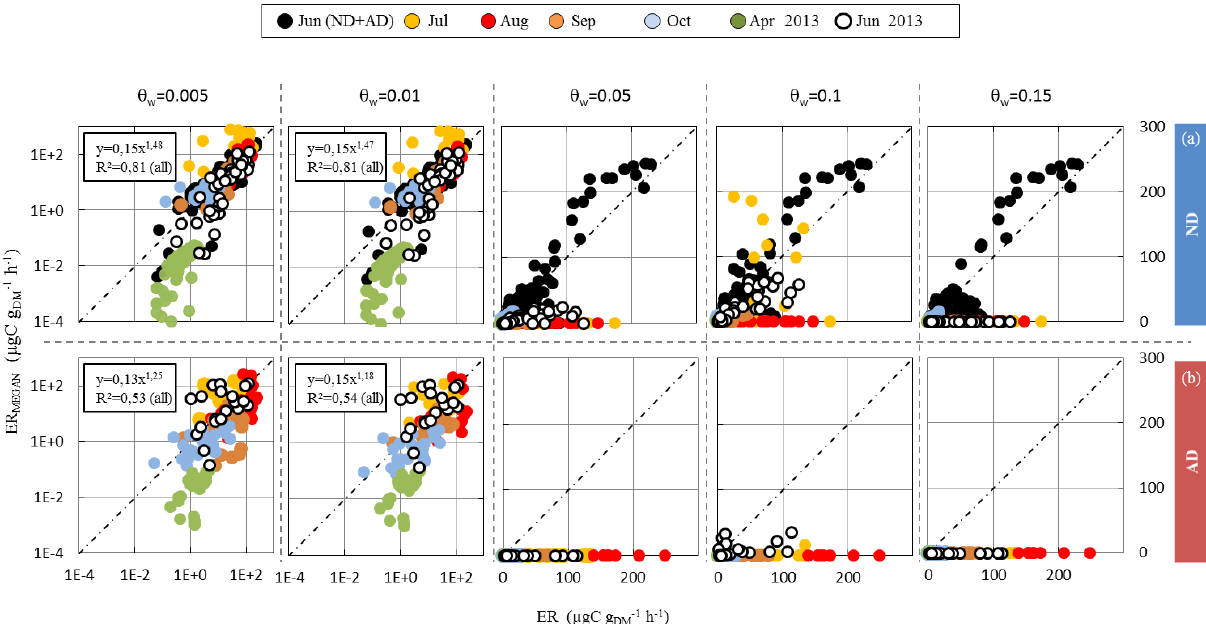
Figure 3. Comparison between isoprene emission rates (in µgCg − 1 h − 1 ) calculated using MEGAN2.1 (ER MEGAN , Guenther et al., 2012) DM and measured isoprene emission rates (ER) vs. the wilting point value θw (0.005 to 0.15m 3 m − 3 ) , from June 2012 to June 2013, under (a) ND ( n = 267) and (b) AD ( n = 138). Since the rain exclusion device was only implemented soon prior to our study’s commencement in June 2012, the ND and AD measurements were considered together for June 2012. Linear regressions for ND June 2012 were y = 1 . 13 x − 12 . 05, R 2 = 0 . 80 ( θw = 0.05m 3 m − 3 ) ; y = 1 . 13 x − 7 . 13, R 2 = 0 . 80 ( θw = 0 . 1m 3 m − 3 ) ; and y = 1 . 12 x − 16 . 94, R 2 = 0 . 76 ( θw = 0.15m 3 m − 3 ) . The dotted line is the 1 : 1